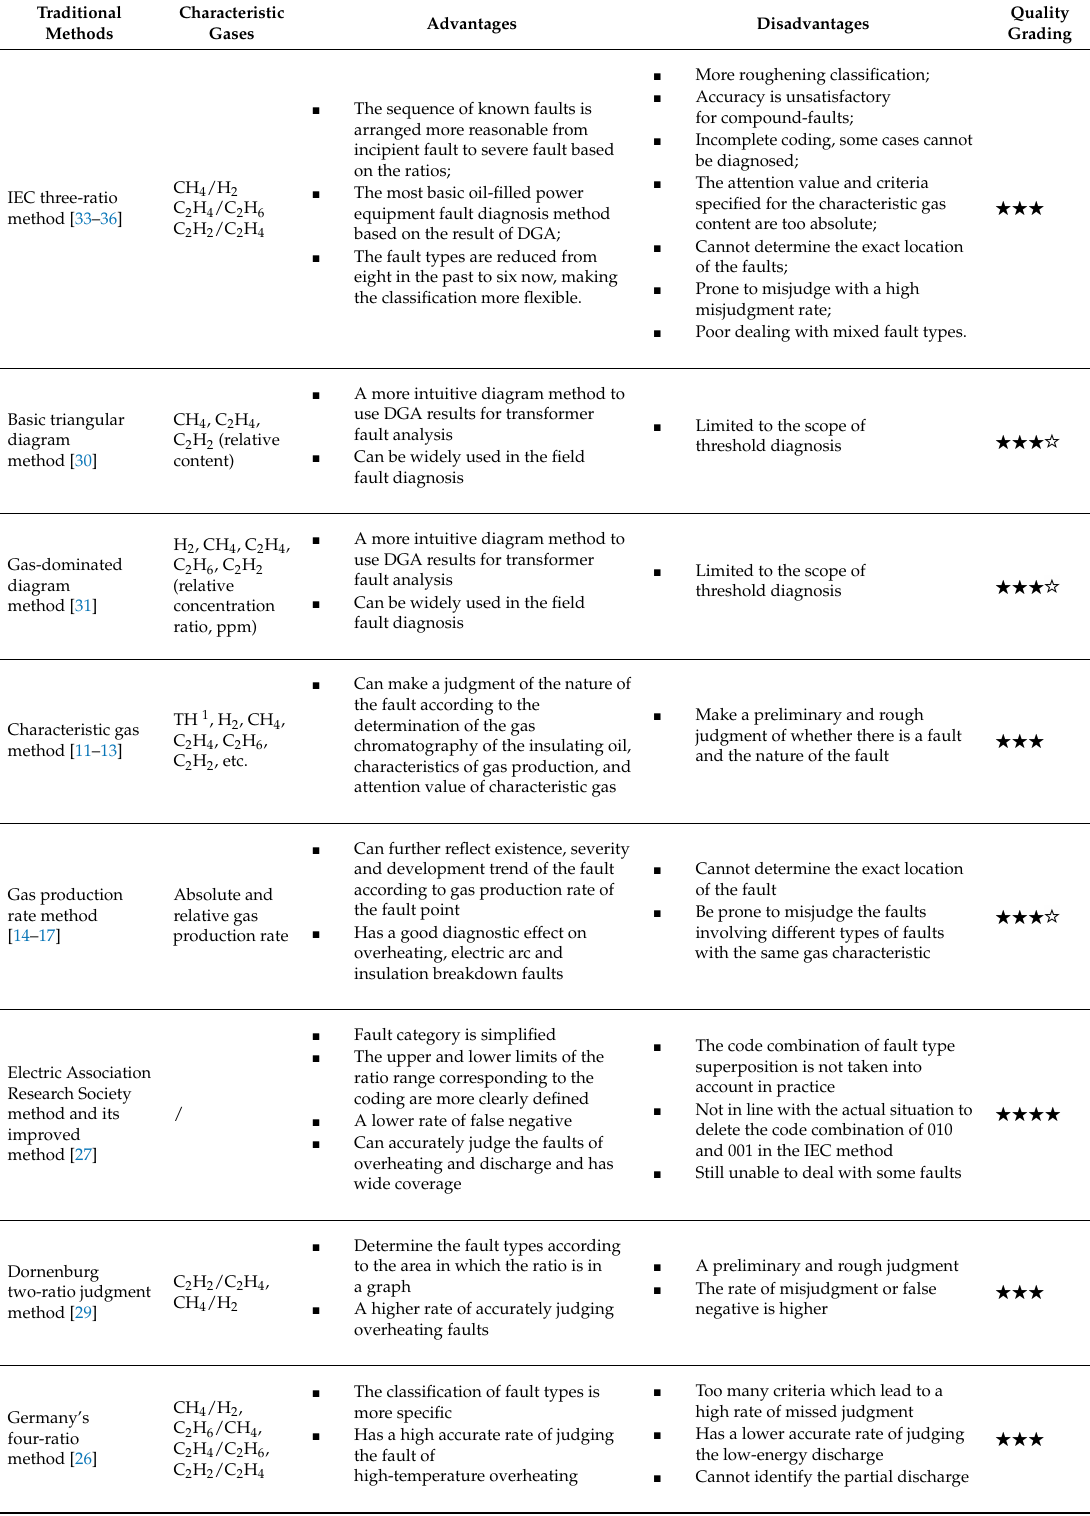
Table 4. AcomprehensivecomparisonofthetraditionalDGAbasedratiomethodsinactualtransformerfaultdiagnosis. Traditional